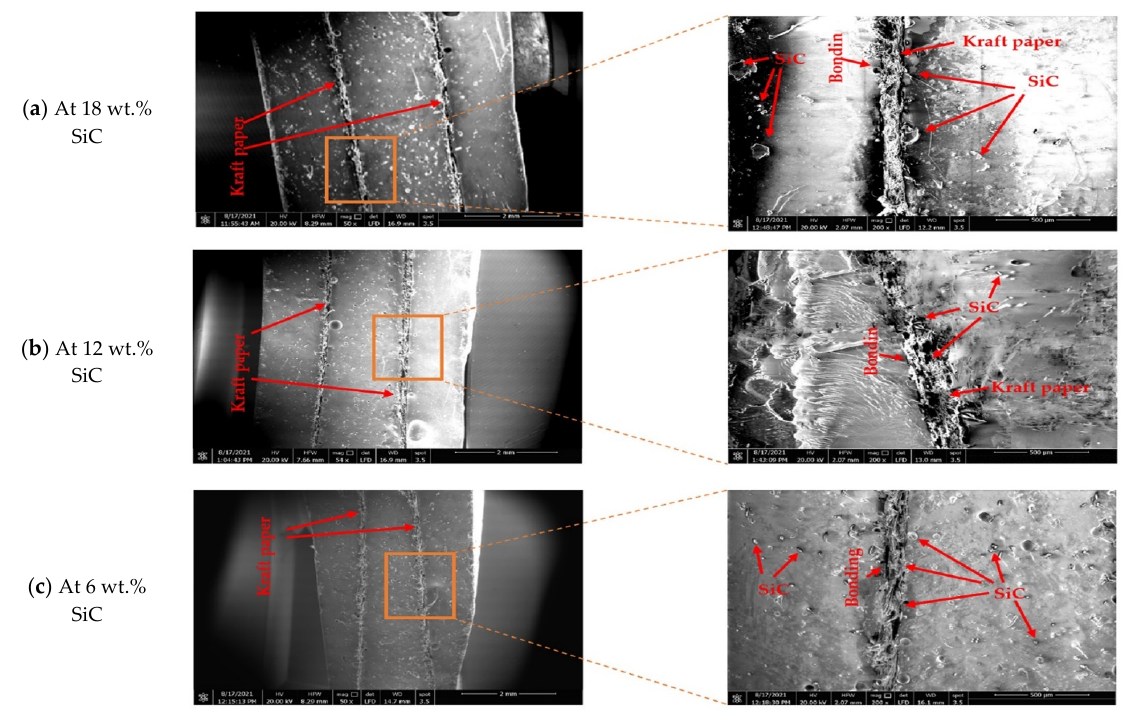
Figure 6. SEM images of composites showing distribution of ceramic particles in epoxy with two magnifications: ( a ) 18 wt.% SiC, ( b ) 12 wt.% SiC, ( c ) 18 wt.% SiC.